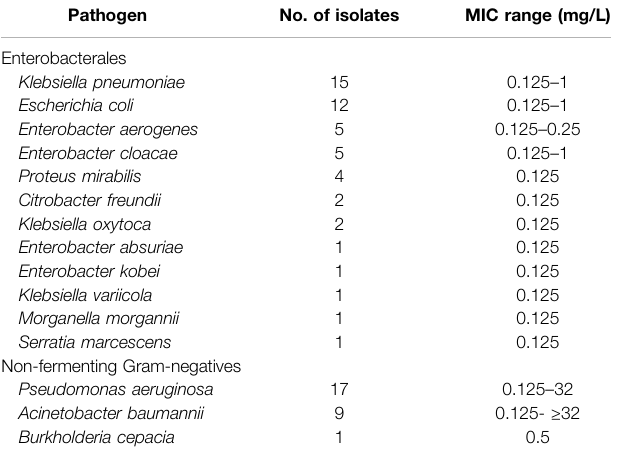
TABLE 2 | Gram-negative pathogens ( n (cid:1) 77 from 44 patients) included in the pharmacokinetic/pharmacodynamic analysis. Pathogen